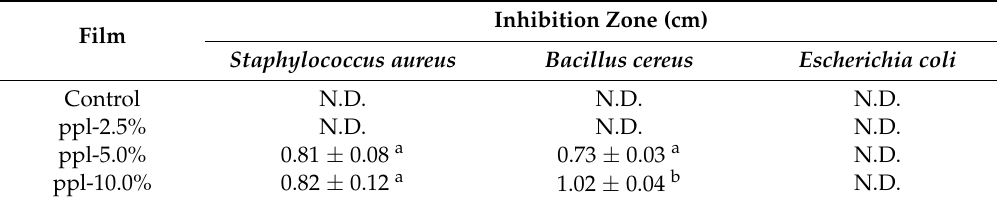
Table 3. Antibacterial activity of different rice starch/CMCh/ppl blended